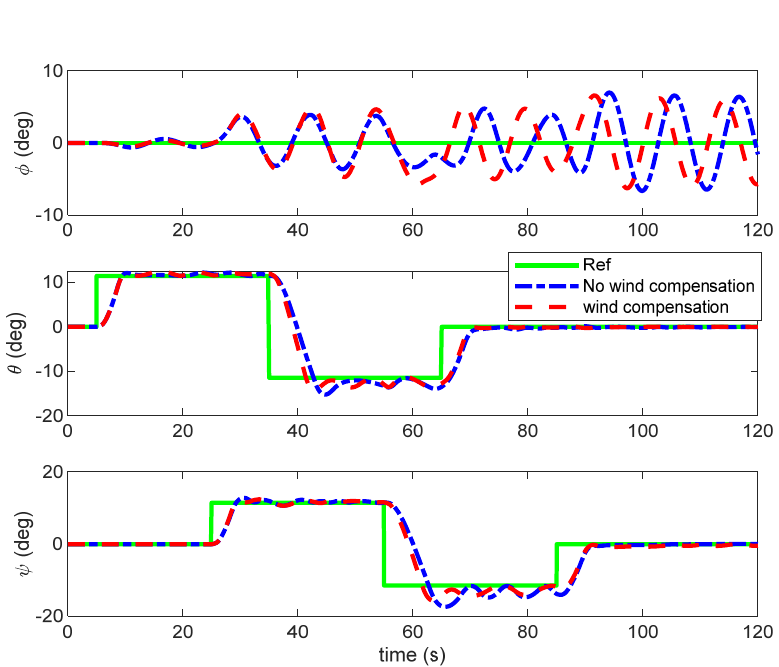
Figure 5. Tracking responses of Euler angles with and without wind compensation. Table 4. Tracking errors and ET of the airship under the input of the controller with wind